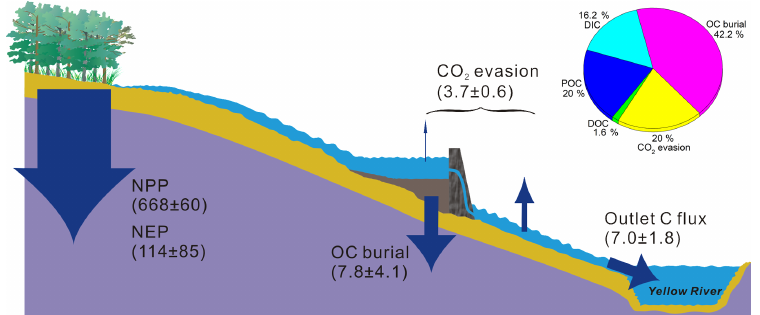
Figure 10. Fluvial carbon budget within the Wuding River catchment in relation to terrestrial ecosystem production (units: × 10 10 gCyr − 1 ). The inserted pie chart denotes the partitioning of riverine carbon among its five phases with the sum (100%) representing all the carbon entering the river